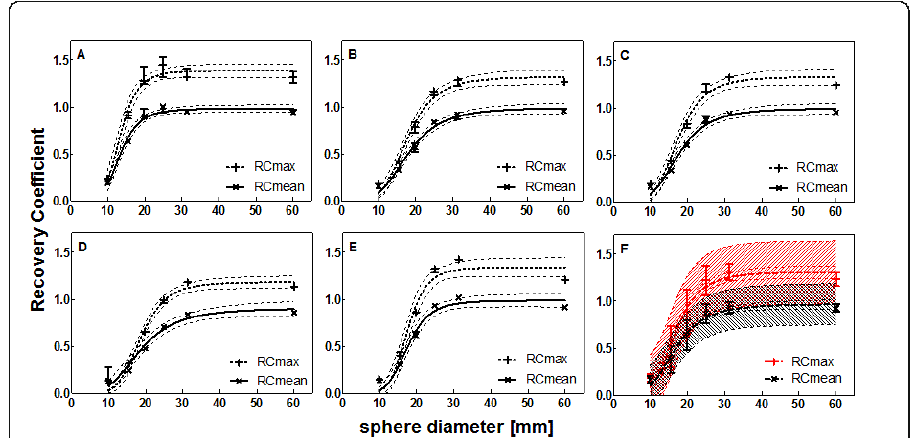
Fig. 3 Recovery coefficient as a function of sphere diameter for all systems separately ( a – e ) and for all systems combined ( f ), for data reconstructed with a vendor-specific algorithm. Median and range of three repetitive measurements per system. a Discovery NM/CT 670 Pro. b Symbia Intevo Bold with xSPECT Quant. c Symbia Intevo Bold with Broad Quantification. d Symbia T16 system 1. e Symbia T16 system 2. f Mean and standard deviation. All data were fitted with a 3-parameter logistic function (dashed line: 95% CI), for the combined data ( f ) also the 95% prediction interval is indicated (dashed area)